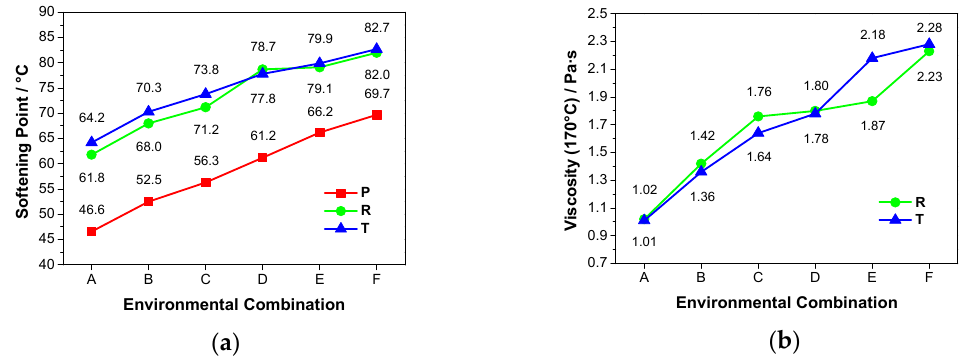
Table 4. Adaptability to environmental factors.